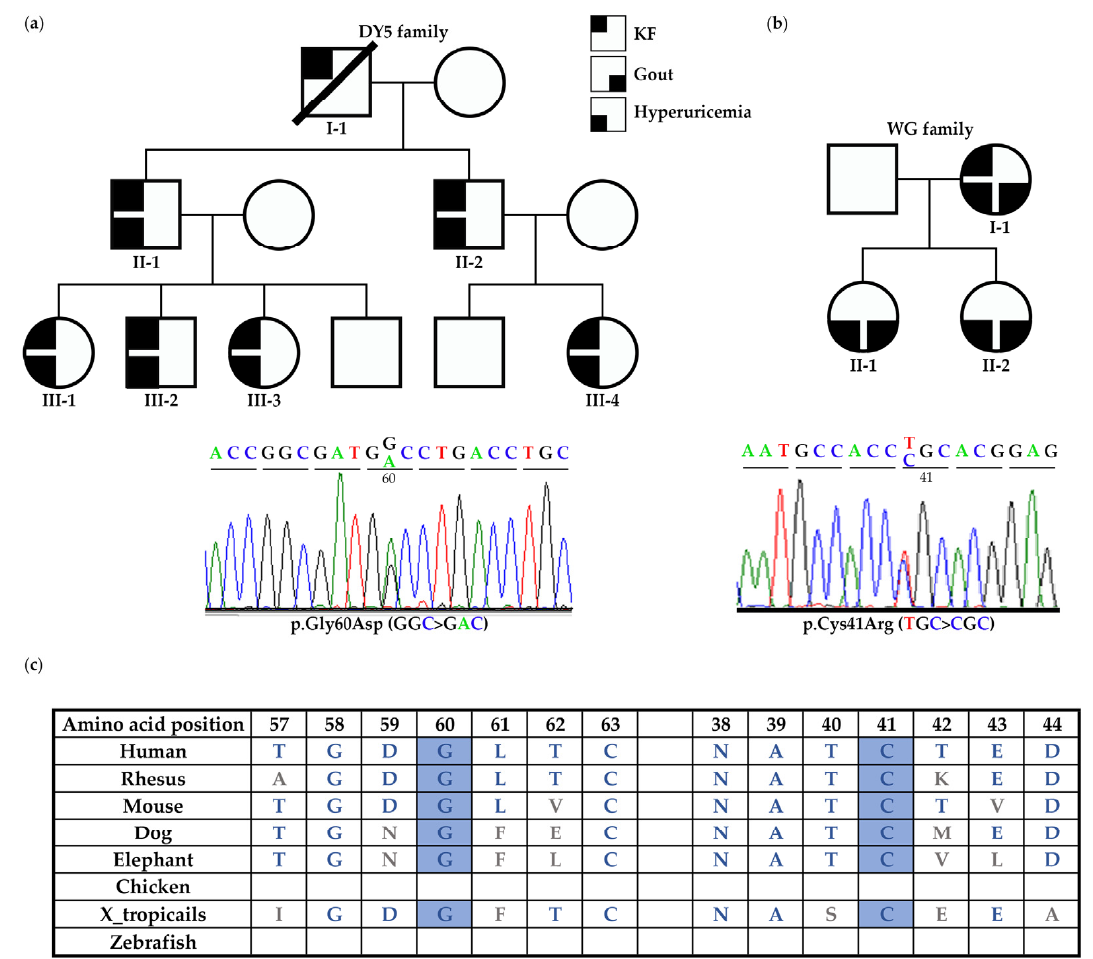
Figure 1. Pedigree and Sanger sequencing electropherogram showing UMOD variants in DY5 and WG families. ( a ) In the DY5 family, the UMOD p.Gly60Asp variant was shared among all the affected individuals. All the affected members had hyperuricemia but no gout episode and entered KF between the ages of 26 and 41. ( b ) The UMOD p.Cys41Arg variant was identified in the WG family. The affected members had gout, hyperuricemia, and CKD or KF. ( c ) The amino acids of Cys41 and Gly60 are well-conserved across different species.